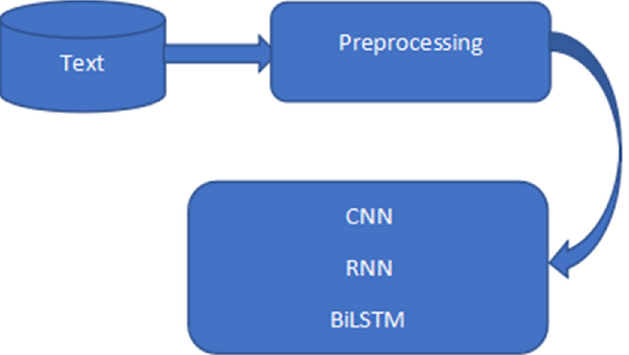
Figure 3 . CNN, RNN, BiLSTM architecture . Figure 3. CNN, RNN, BiLSTM